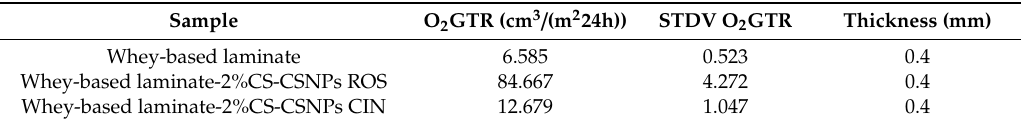
Table 2. Oxygen permeability of whey-based